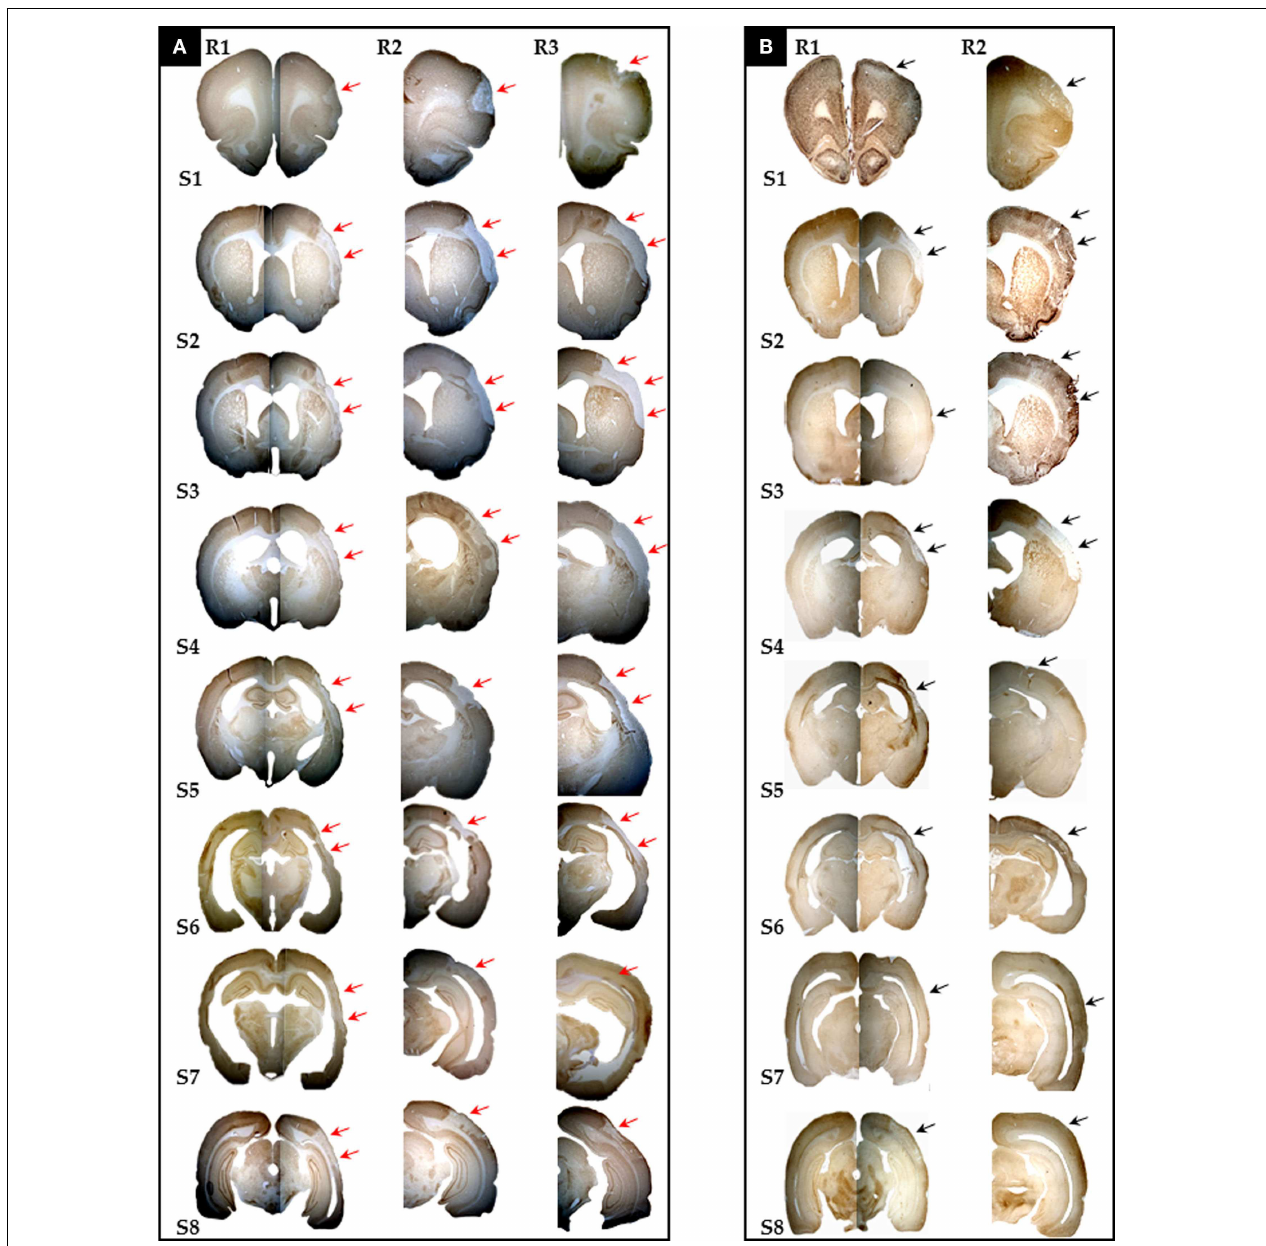
FIGURE 1 | Photomicrographs (10 × ) of eight coronal brain sections stained with NeuN and selected for the sake of illustration to span the whole MCA territory (S1–8 = Bregma + 2.70mm, + 1.00mm, -0.26mm, -0.92mm, -2.12mm, -3.14mm, -4.52mm, and -6.04mm, respectively) from all three rats (R1 to R3) with 30min MCAo [(A), n = 3] and two rats (R1 and R2) subjected to 22min [(B), n = 2] MCAo, showing the presence